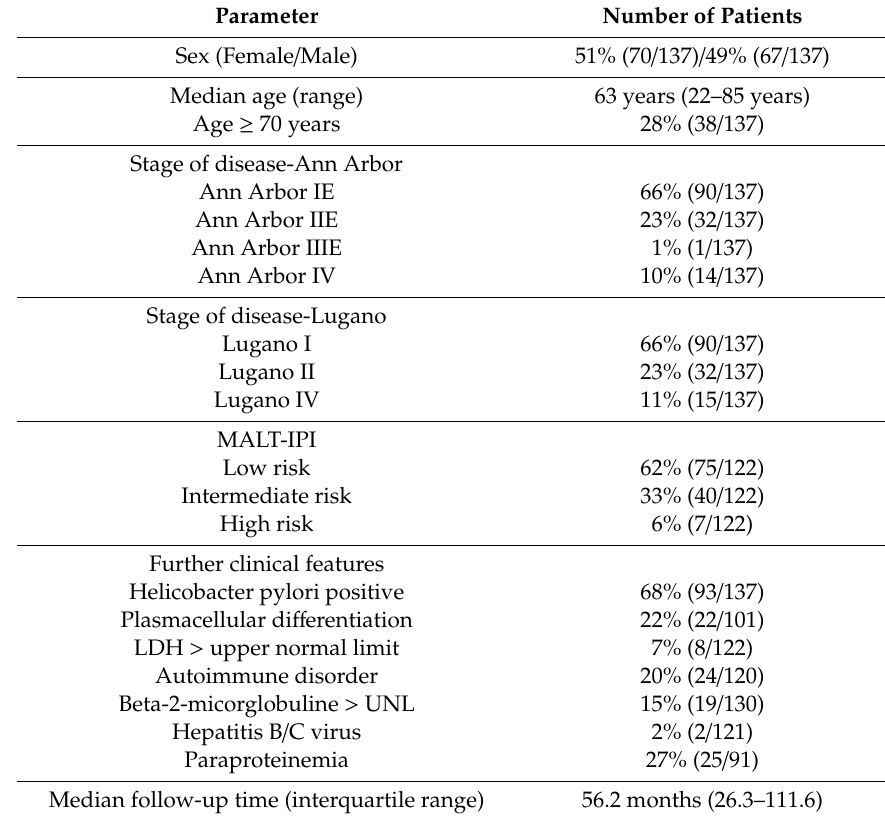
Table 1. Baseline characteristics gastric mucosa-associated lymphoid tissue (MALT) lymphoma patients ( n = 137